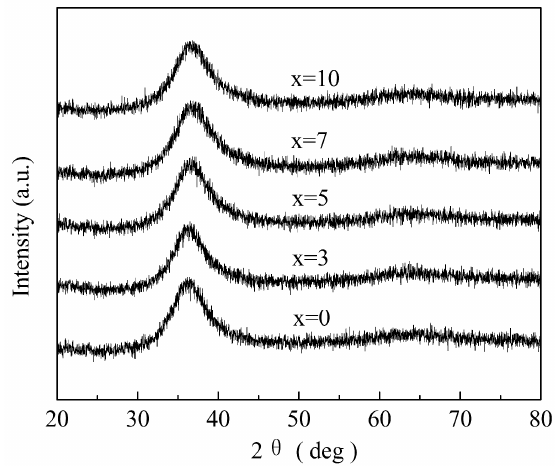
Figure 2. XRD patterns of the Zr 70 − x Cu 12.5 Ni 10 Al 7.5 Ag x alloys.